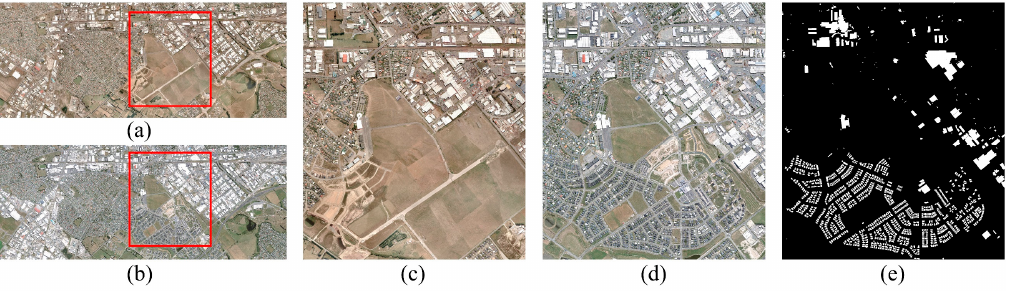
Figure 5. Building change detection dataset, obtained in ( a ) 2012 and ( b ) 2016; ( c ) Study area-2012; ( d ) Study area-2016; ( e ) Ground truth, where white indicates changed region and black indicates the unchanged region.